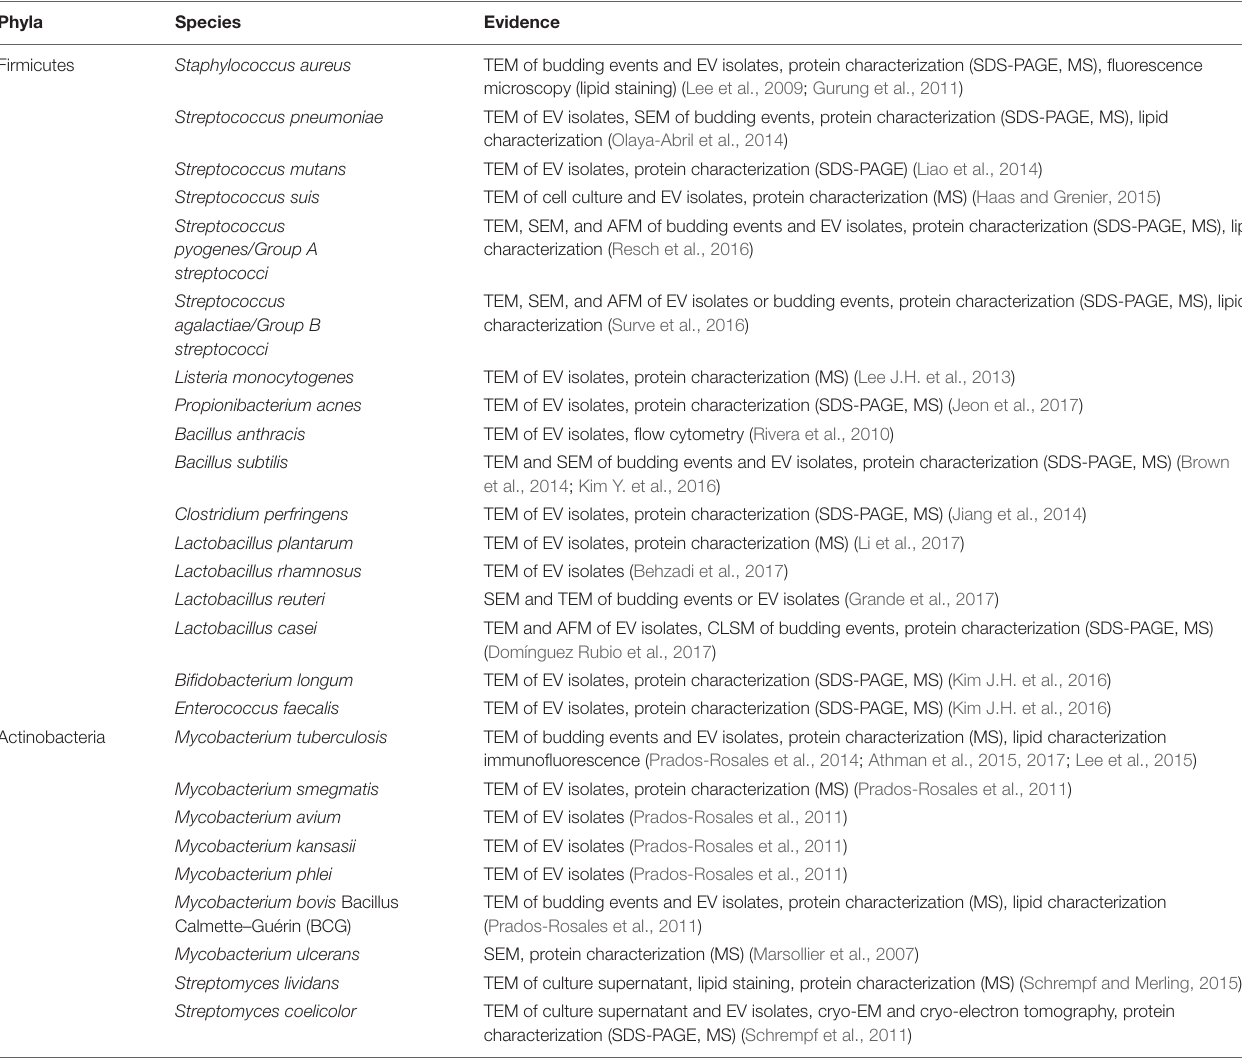
TABLE 1 | Gram-positive organisms for which EV release has been demonstrated. Phyla Species Evidence